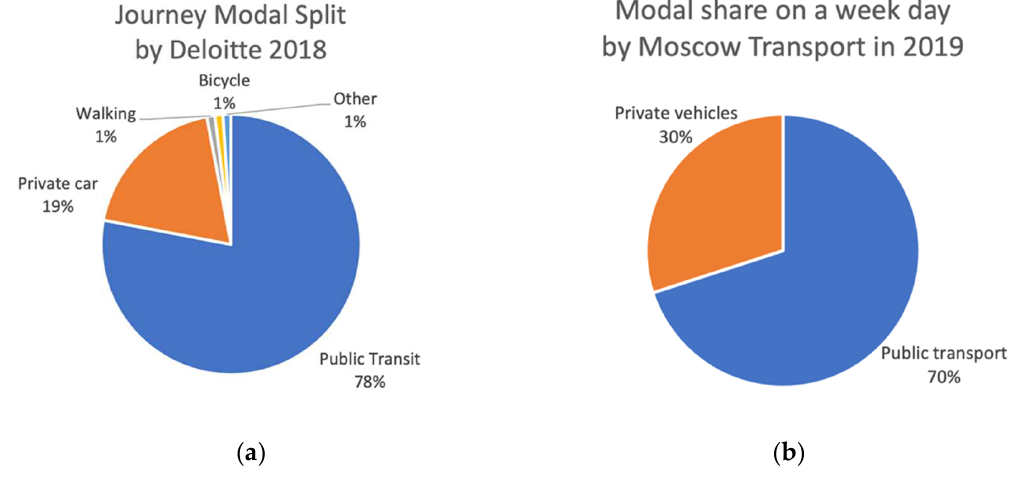
Figure 1. Modal split in Moscow: ( a ) Journey Modal Split by Deloitte 2018 [65]; ( b ) modal share on a weekday by Moscow Transport in 2019 [2].